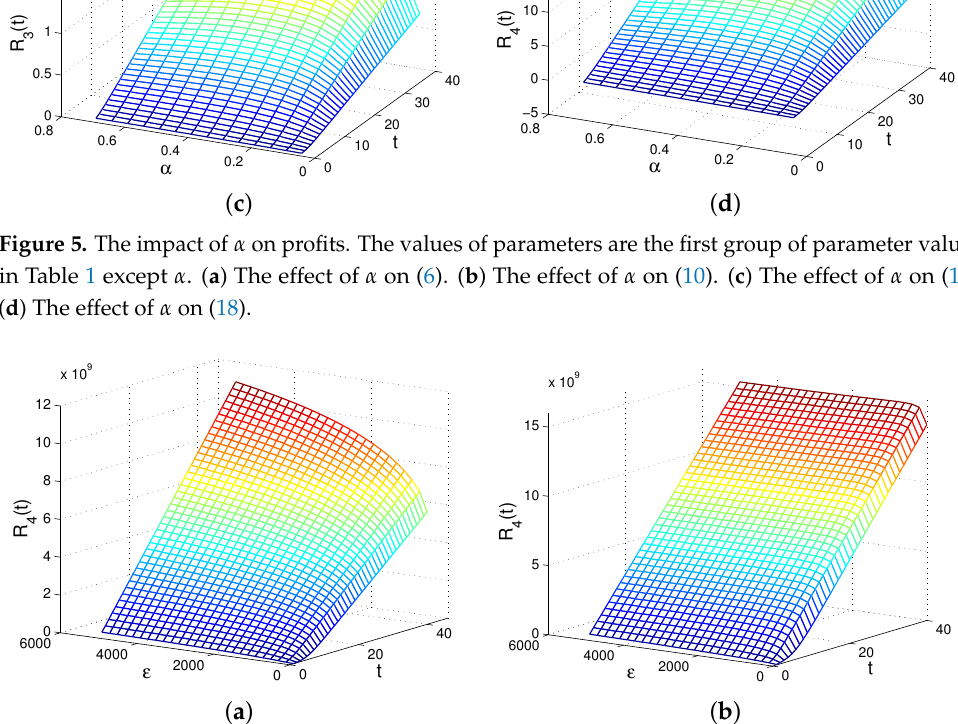
Figure 6. The impact of ε on profits. The values of parameters are the first group of parameter values in Table 1 except ε . ( a ) The effect of ε on (14). ( b ) The effect of ε on